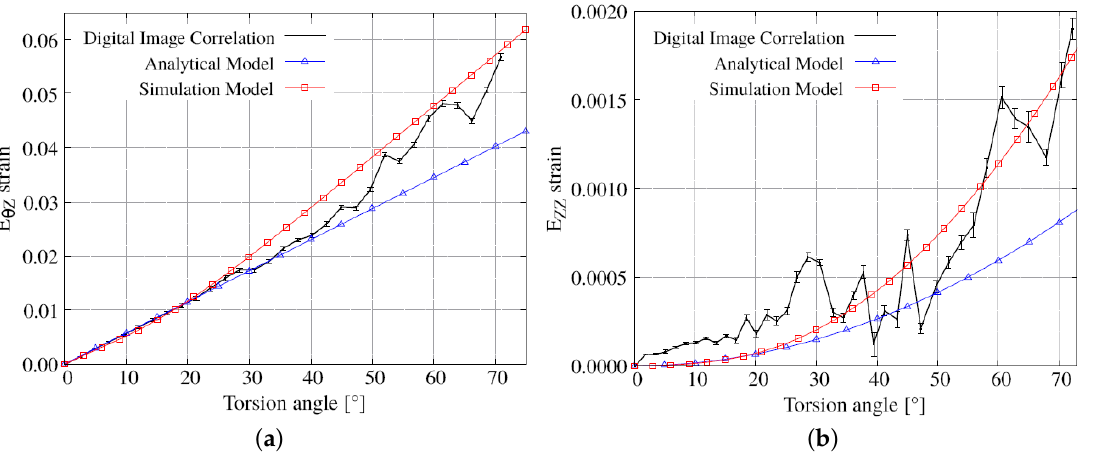
Figure 13. Average experimental, analytical, and numerical results for the strain components ( a ) E θ Z , NRMSD = 6.5% and ( b ) E ZZ , NRMSD = 8.6%, expressed as a function of the torsion angle at the edge of the